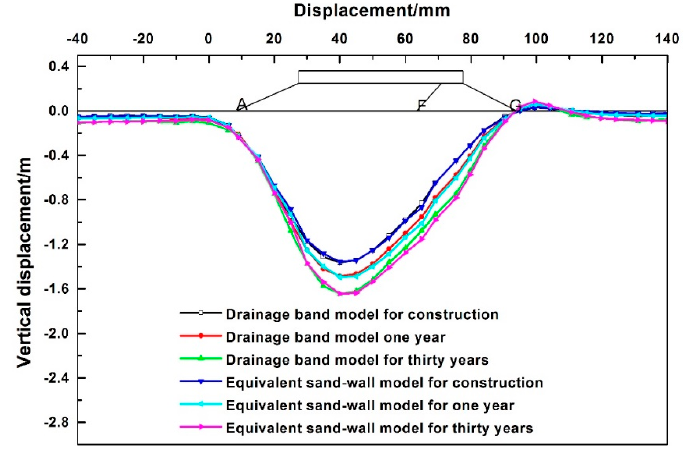
Figure 12. Settlement curve of the drainage plate model and equivalent sand-wall model at a height of 7 m.